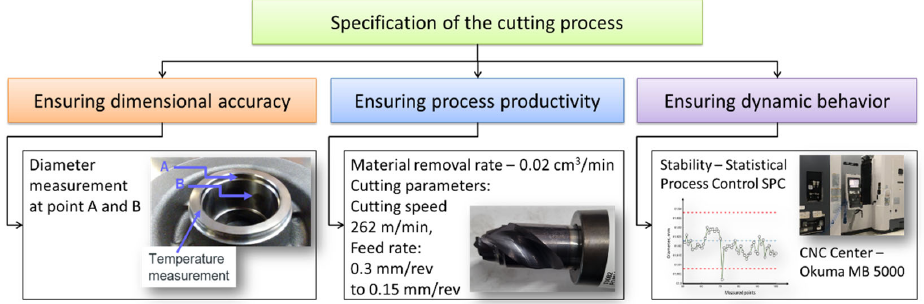
Figure 1. Requirements for the cutting process.